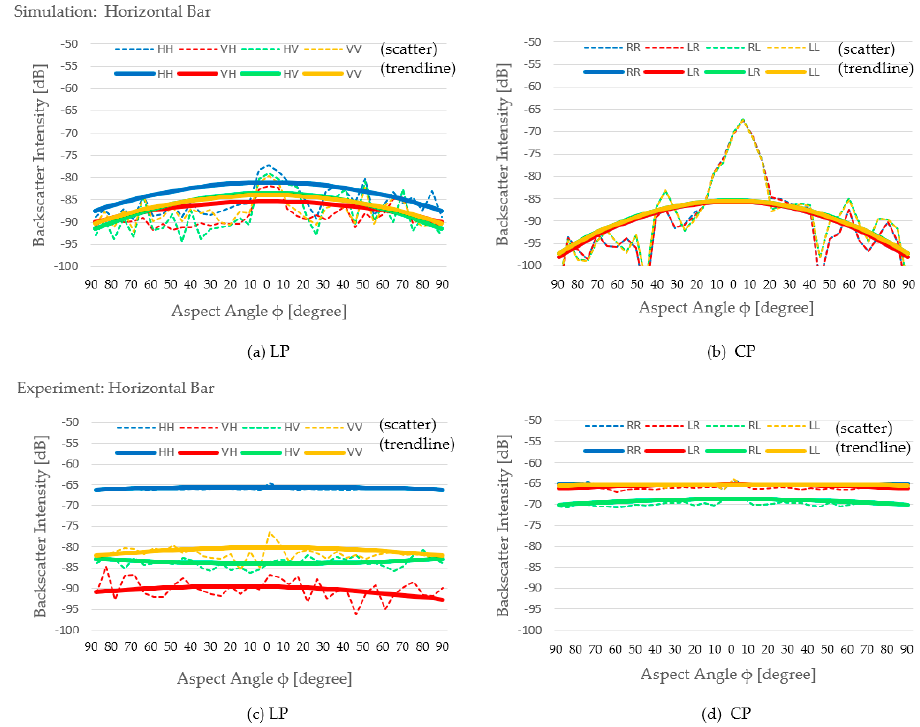
Figure 11. Backscatter intensity of a medium-sized horizontal bar ((l / λ = 6.3, w / λ = 0.4): ( a ) Simulation result of LP, ( b ) simulation result of CP, ( c ) experimental result of LP, and ( d ) experimental result of CP.